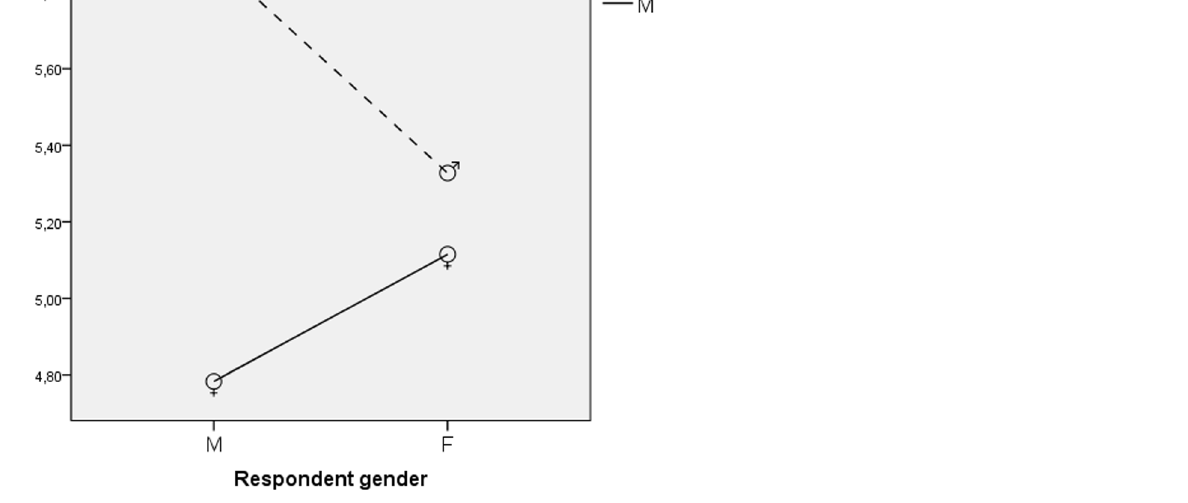
Figure 3. Interaction of respondent gender and target gender: Evaluation of the target in terms of conscientiousness mean